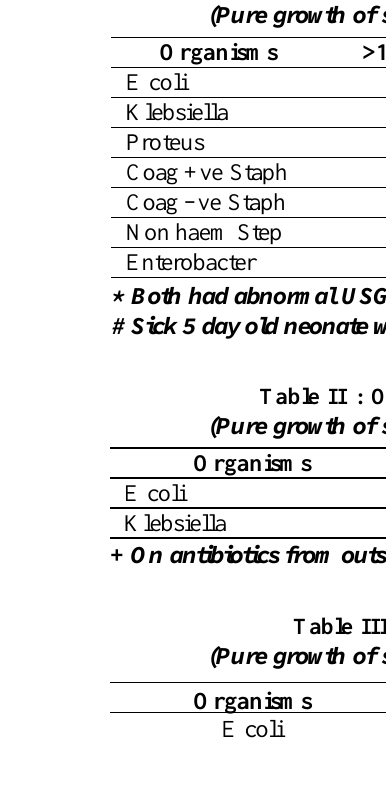
Table I : Organisms isolated in catheter sample